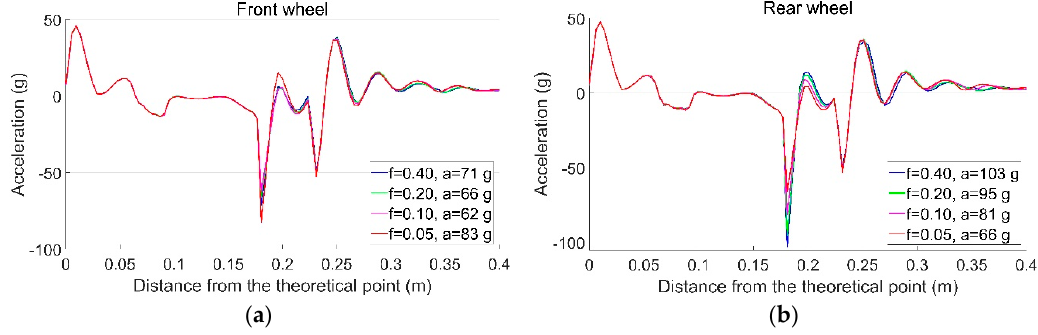
Figure 23. Vertical accelerations of the rail due to the passing wheels. ( a ) Front wheel; ( b ) rear wheel.